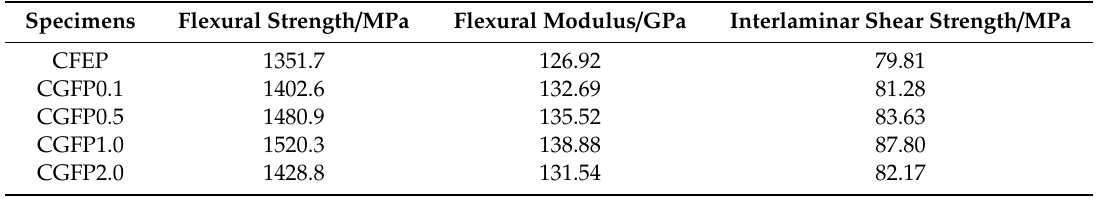
Table 3. Flexural properties and interlaminar shear strength of the AMGNS-MWCNT/CFEP unidirectional composites with different AMGNS-MWCNT content.